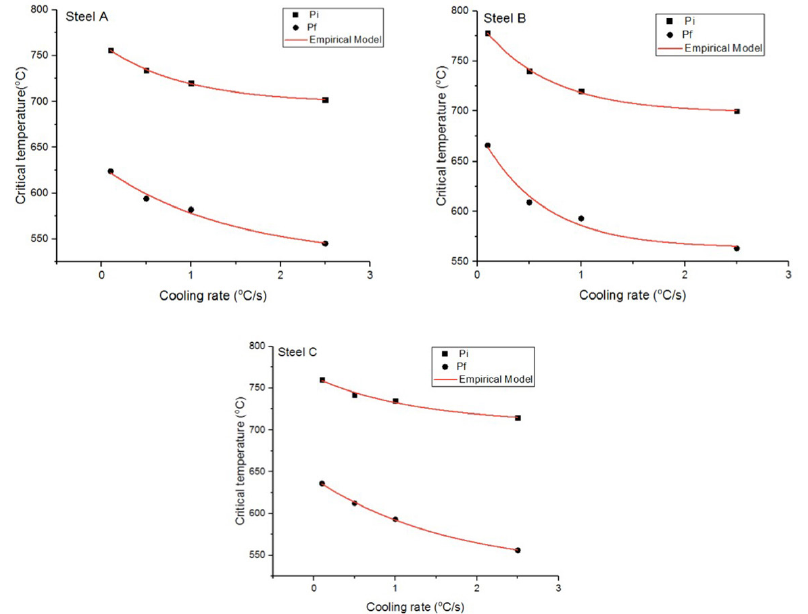
Figure 11. Critical temperatures as cooling rate functions. Empirical model fitted to the experimental data measured for steels A, B and C.